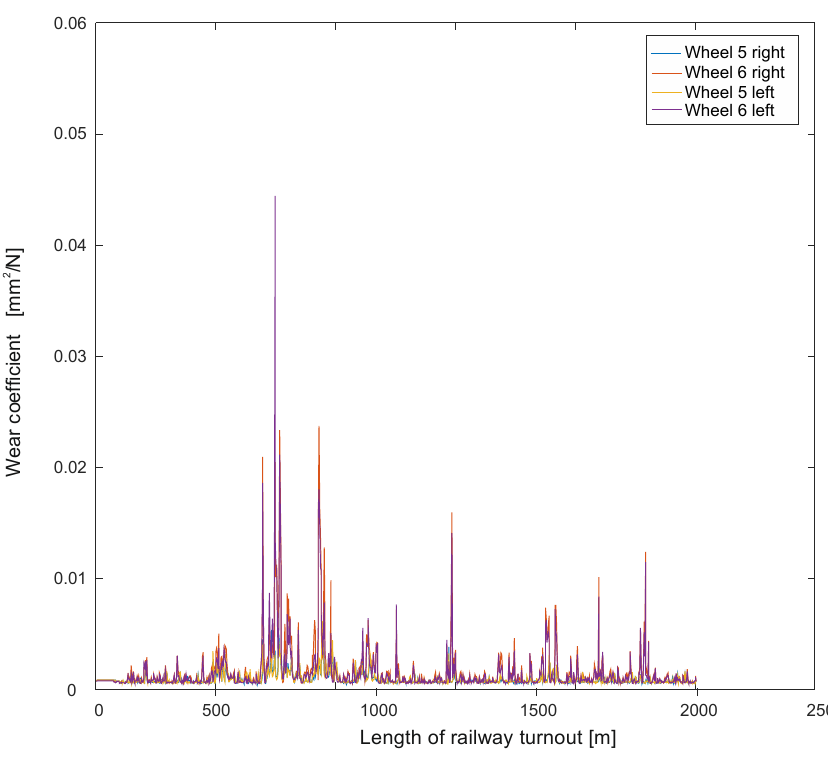
Figure 35. Wear coefficient obtained for a straight track without a turnout at 300 km/h.